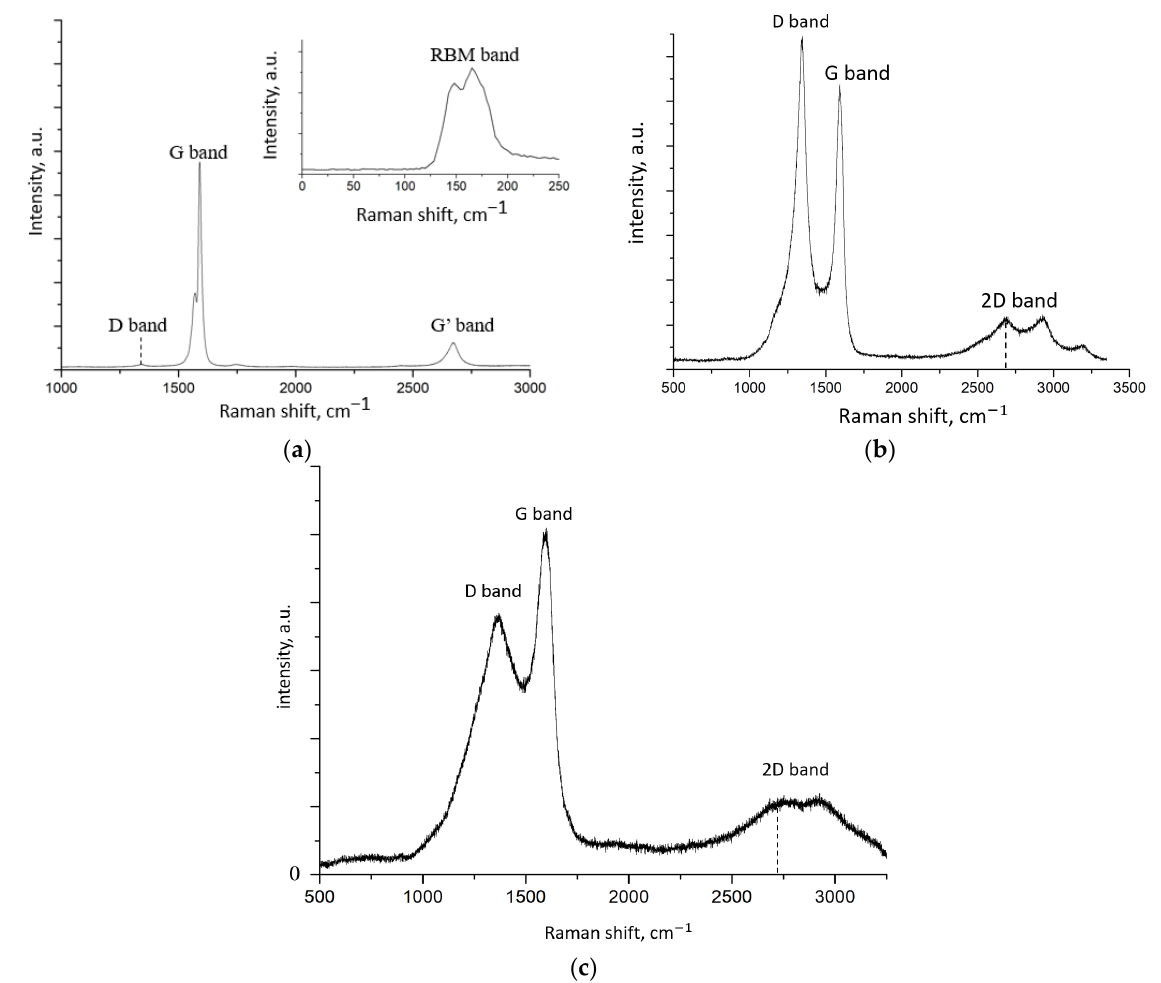
Figure 4. Raman spectra of SWCNT ( a ), graphene nanosheets, synthesized from starch under the conditions of the SHS process ( b ), rGO ( c ).